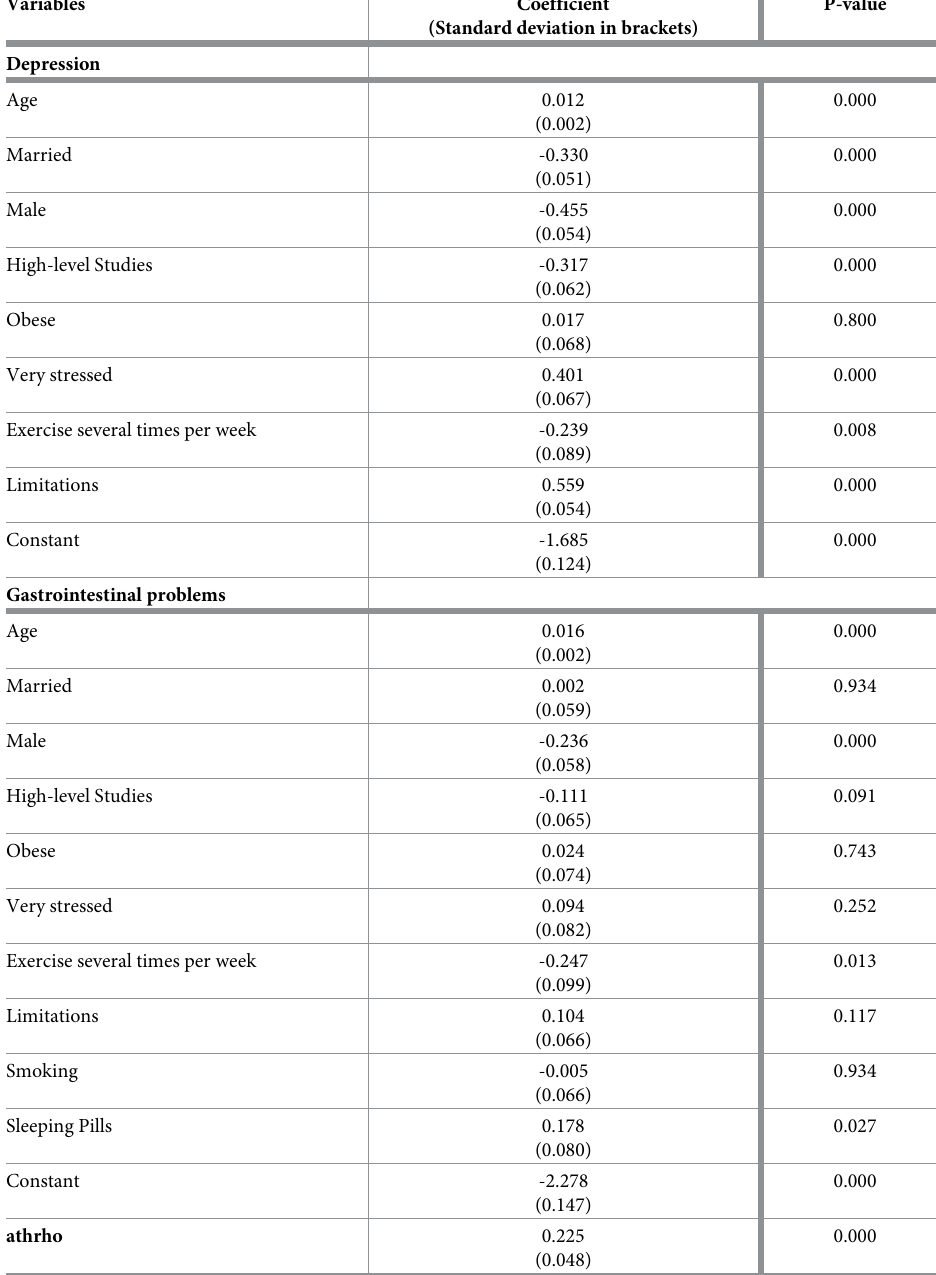
Table 3. Bivariate probit of being depressed and having gastrointestinal